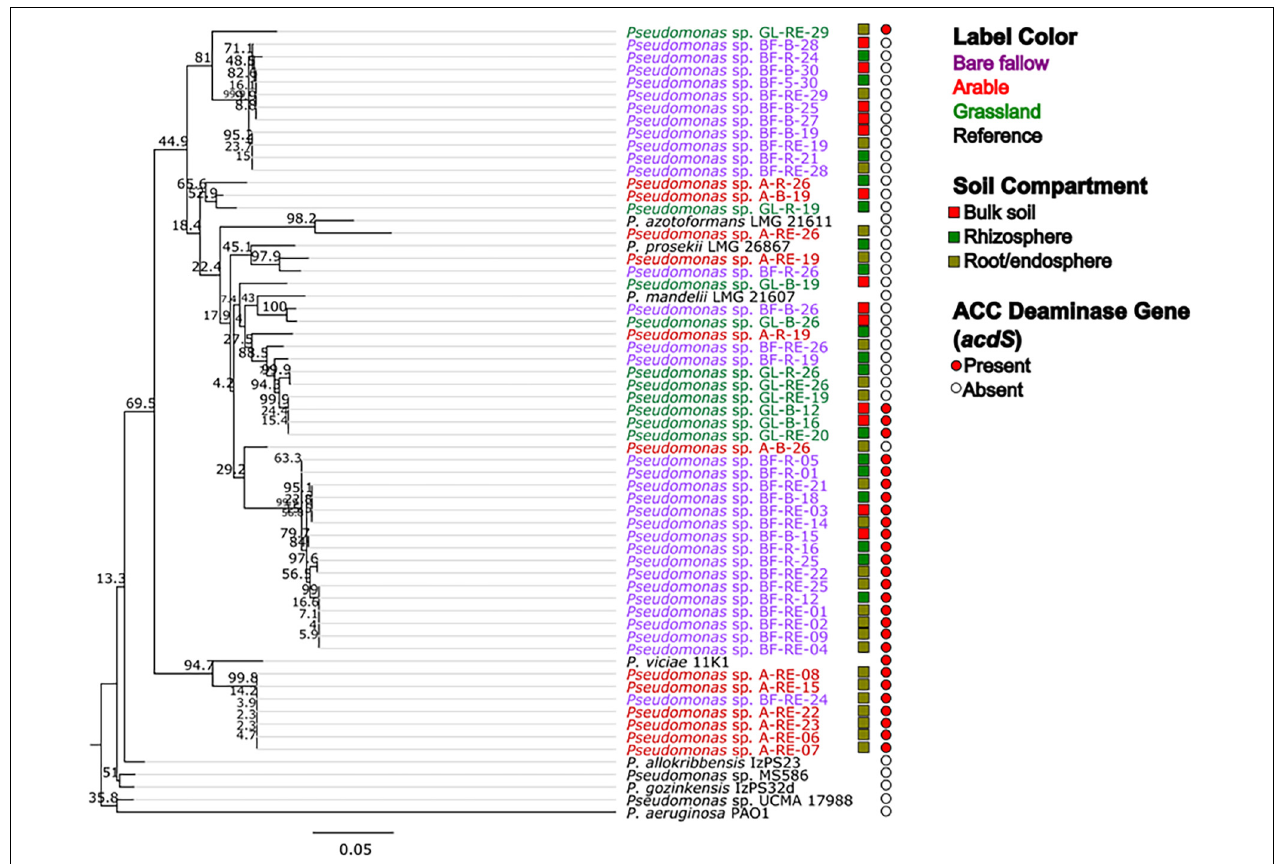
FIGURE 2 | Maximum likelihood (ML) tree based on gyrB nucleotide sequences from genome sequenced Pseudomonas strains associated with wheat grown in soils from three different land managements. The 54 isolates from bulk soil, rhizosphere soil, and roots of wheat grown in three distinct land management regimes (bare fallow, arable, and grassland) were phylogenetically analyzed utilizing a ML tree with a transitional model. Percentage bootstrap are indicated at branching nodes. Branch labels are colored to indicate the soil management where the bacteria was isolated and boxes beside labels indicate the soil compartment. Circles indicate the presence or absence of acdS gene in the genome of the